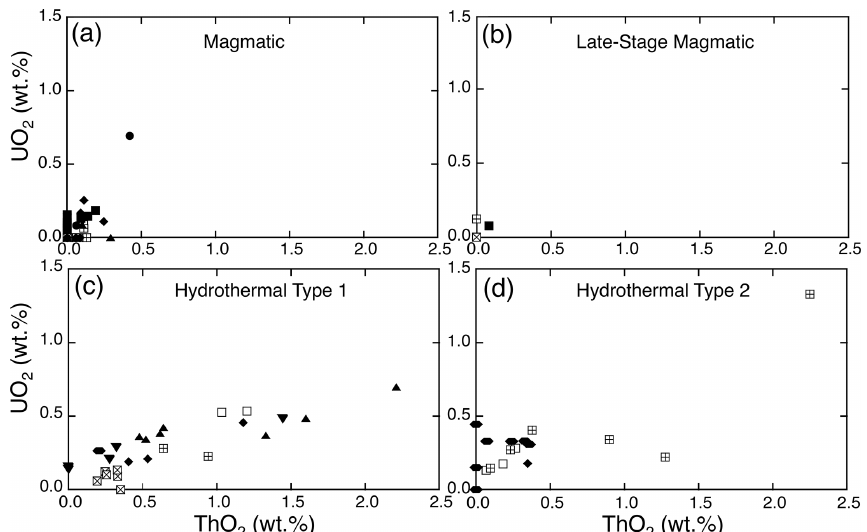
Figure 6. Variation in ThO 2 versus UO 2 (wt%) in the studied zircons: (a) magmatic, (b) late-stage magmatic, (c) hydrothermal type 1, and (d) hydrothermal type